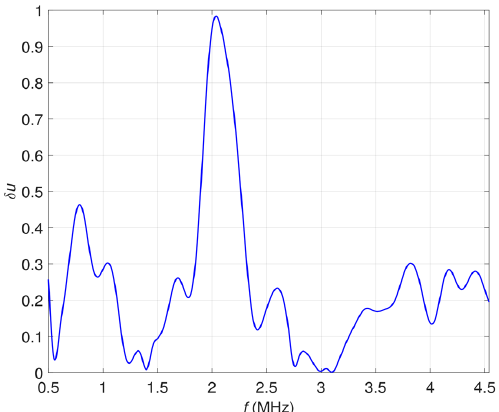
Figure 5. Relative voltage changes δ u caused by the material influence plotted as a function of the excitation frequency f.